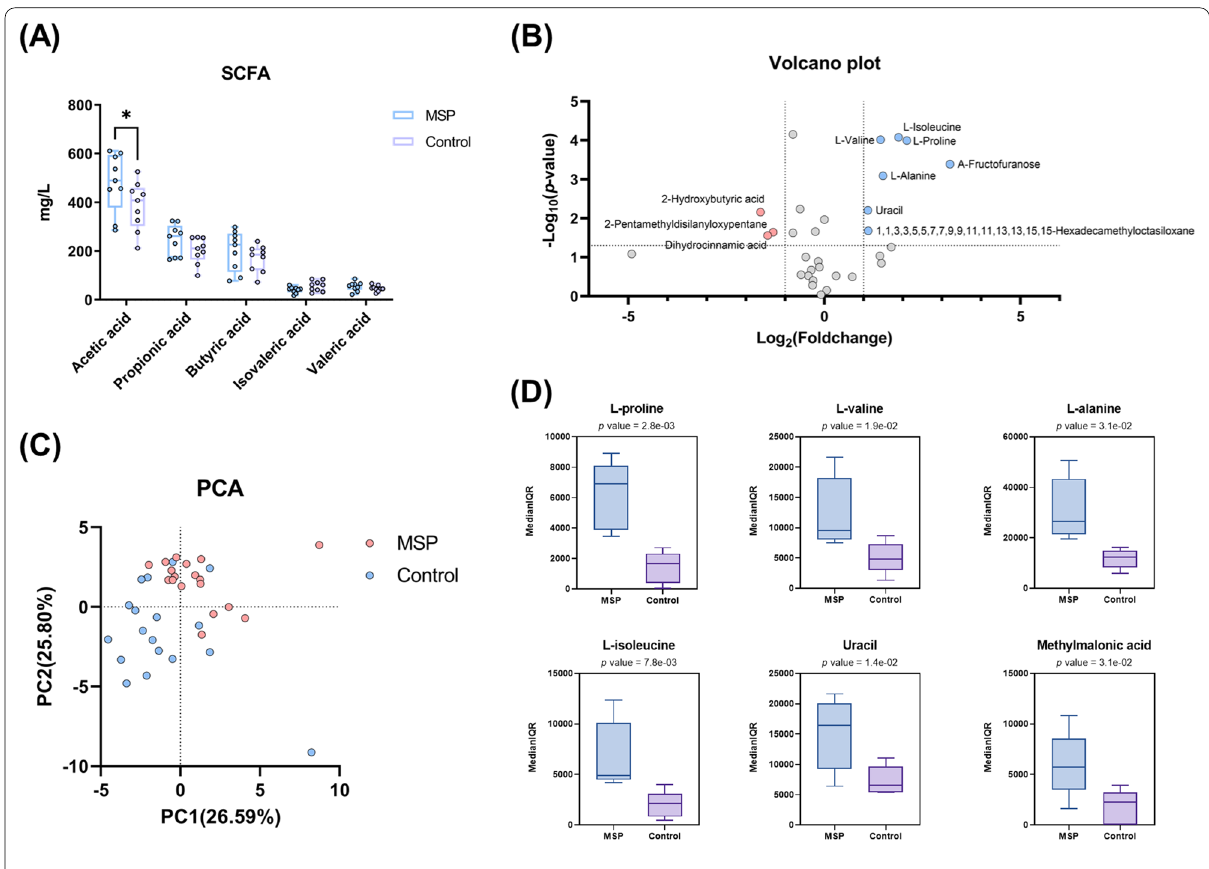
Fig. 4 Difference concentration and variation of SCFAs and metabolites compared with MSP and control piglets. Metabolomic analysis of piglet feces at 6 weeks. A SCFA profiling using HPLC–MS/MS. B The results of the volcano plot analysis showed that 7 peak pairs (FC > 1, p increased, whereas 3 peak pairs (FC < 1, p 0.05) were reduced. All metabolites that were positively and putatively identified with high confidence ≤ were matched using the NIST library. C Principal component analysis (PCA) score plots of metabolites in the feces of piglets between the MSP and control groups. D Selected metabolite and bacterial boxplots showed differences between the MSP and control groups. Mean (SD) values of each group are provided by Student’s t test. Median (IQR) values are provided by the Mann–Whitney U